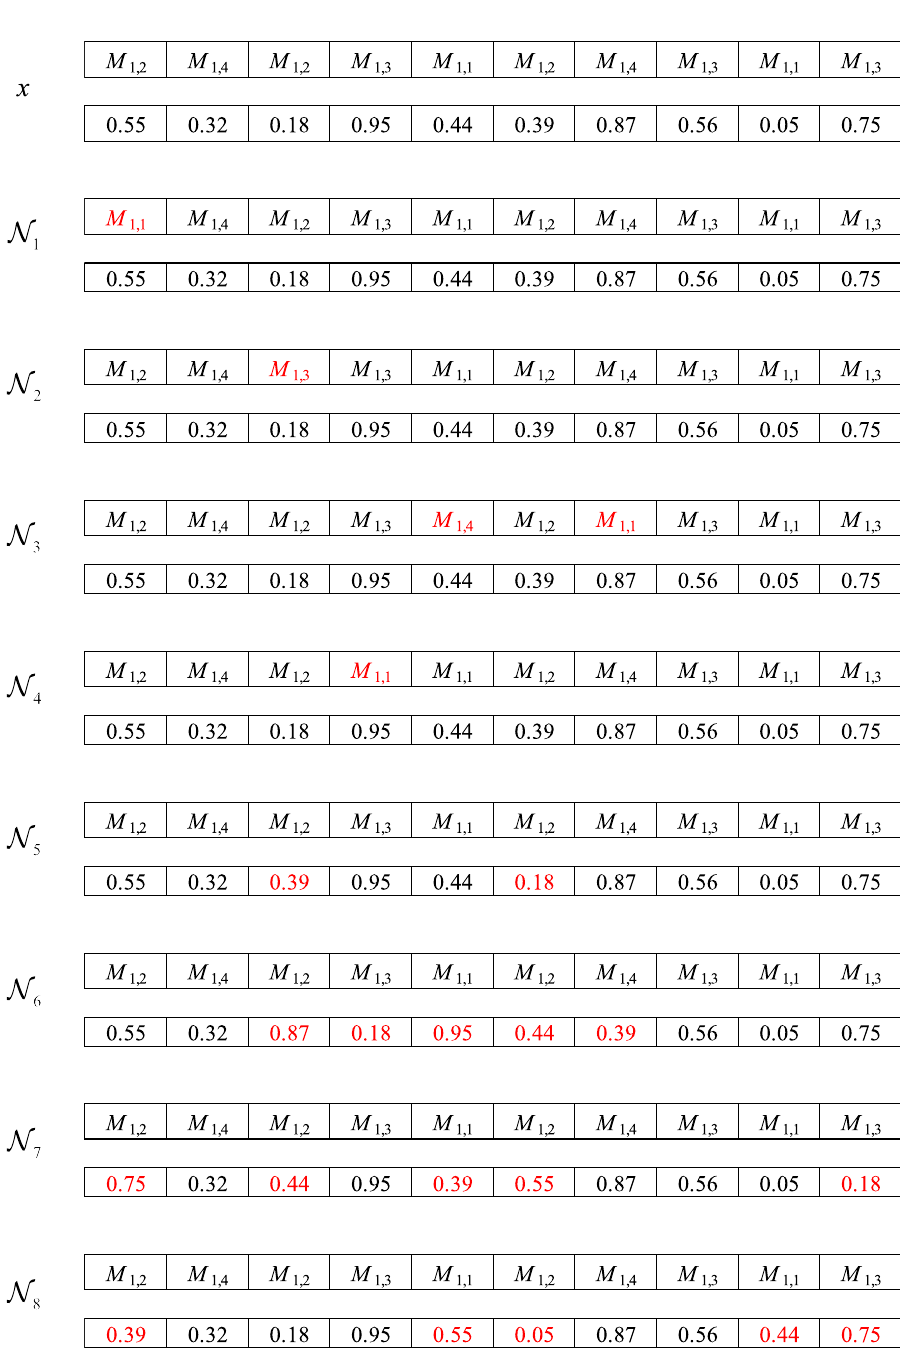
Figure 3. The explanation of 8 neighborhood